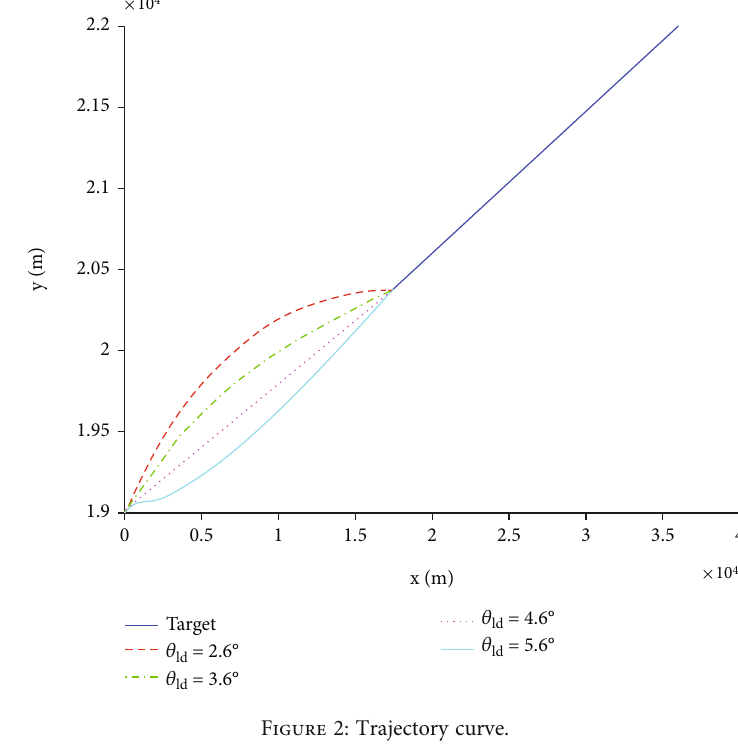
Figure 2: Trajectory